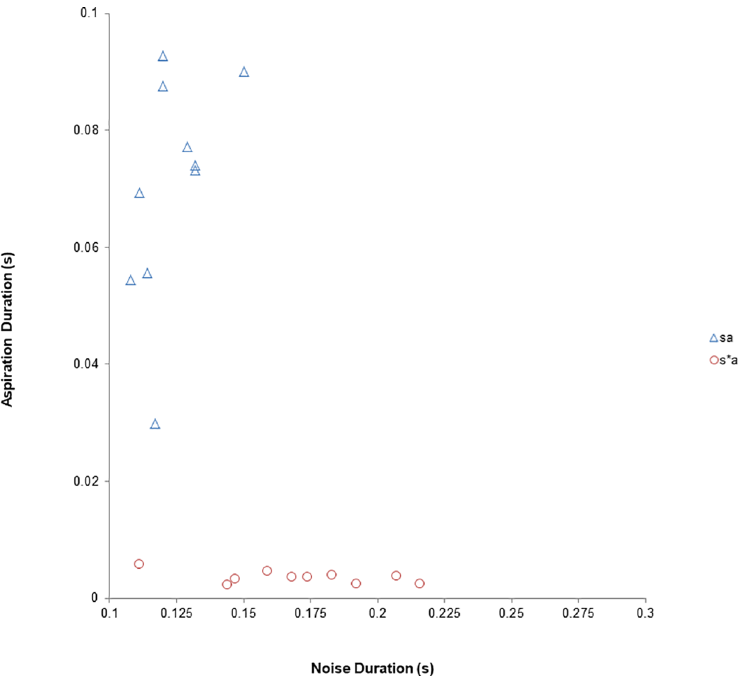
Fig 1. Distribution of lenis /sa/ and fortis /s (cid:3) a/ tokens as a function of aspiration and frication noise duration used in the study. Circles represent fortis fricatives; triangles represent lenis fricatives. The data represent tokens naturally uttered by a female native Korean speaker in IDS